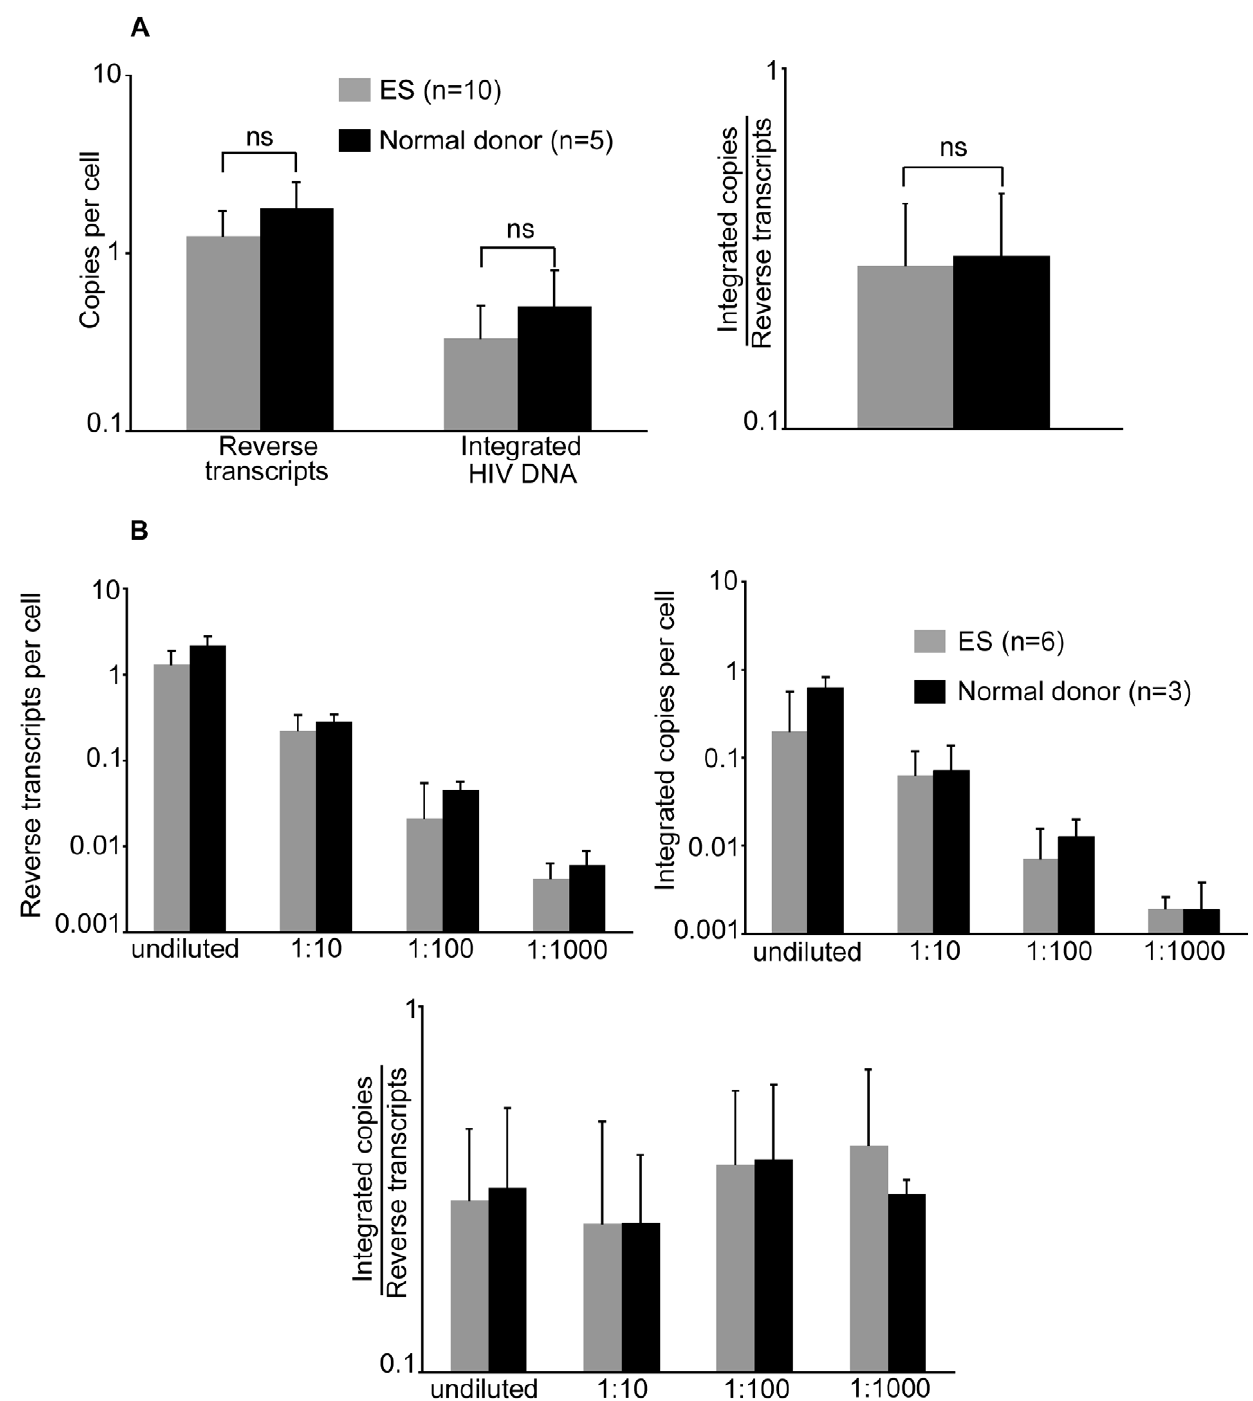
Figure 6. ES CD4 + T cells are not resistant to invitro infection. CD4 + T cells from 10 ES and 6 uninfected donors were inoculated with NL4-3 ( A ). Reverse transcripts and integrated HIV DNA were measured at 2 days post-infection. From these values, integration efficiency was calculated ( i.e. integrated copies per reverse transcript). ES were compared to normal donors with a Wilcoxon rank-sum test. Neither reverse transcription, integration nor integration efficiency measurements were statistically different between the two populations. Six ES were also inoculated with 3 serial ten-fold dilutions of the same virus ( B ). The bars represent the averages of multiple experiments (n is indicated in figures) and the error bars represent the standard deviations.